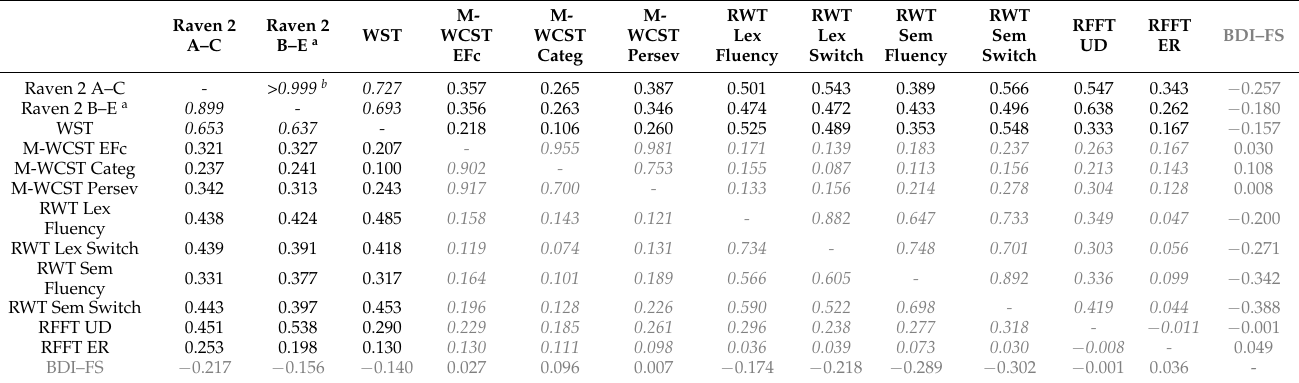
Table 4. Spearman rank correlations between z scores based on observed scores (i.e., r xy ; below diagonal) and based on true scores (i.e., r xtyt ; above